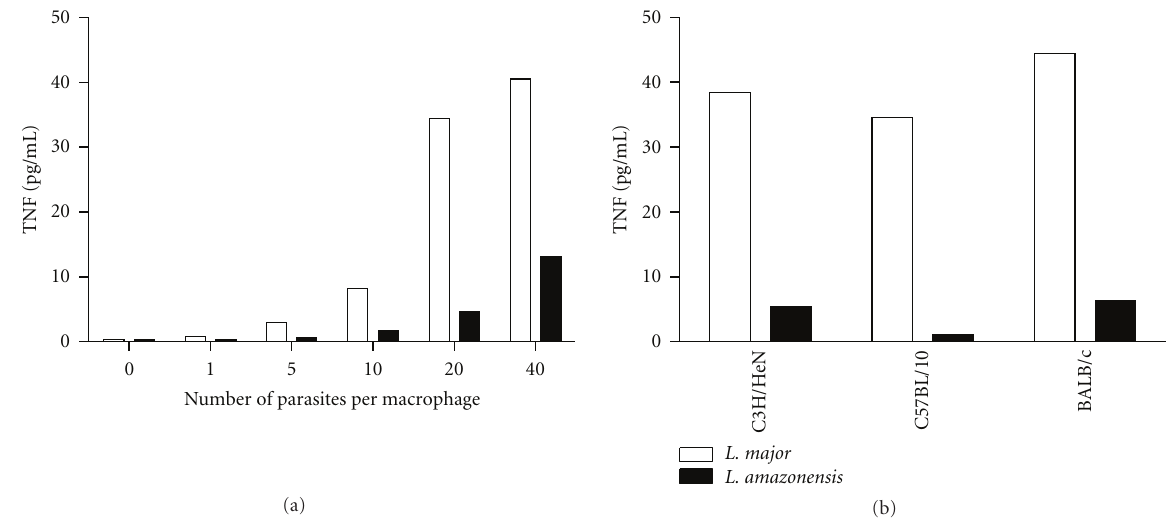
Figure 1: Infection with L. major induces more TNF than infection with L. amazonensis. (a) TNF production by inflammatory macrophages from C57BL/10, mice infected in vitro with L. major or L. amazonensis. (b) Production of TNF ex vivo by lymph node cells from C3H/HeN, C57BL/10 and BALB/c mice infected with L . major or L. amazonensis , 2 days after infection. A biological assay that does not distinguish between TNF- α or TNF- β was used in these experiments. These are representative experiments of more than five performed experiments (L. Q. Vieira and P. Scott,